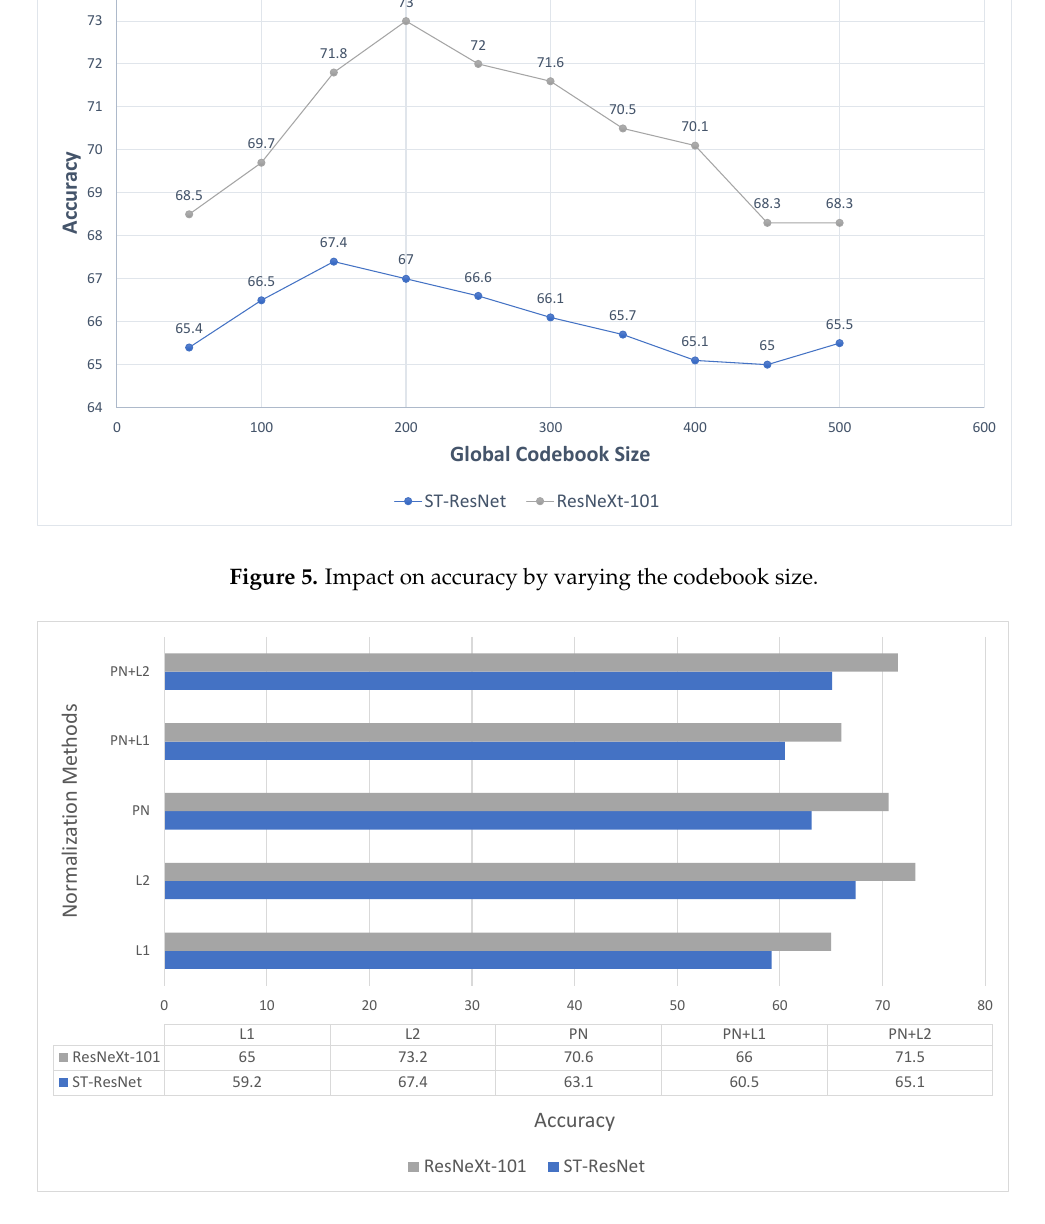
Figure 6. Comparison of different normalization methods on